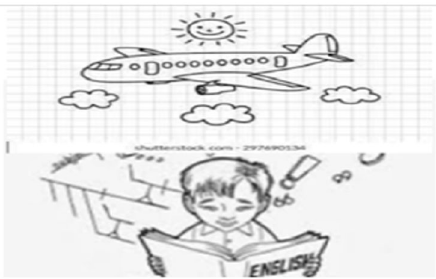
Fig. 2 G1 ’ s adapted metaphorical representation. This fi gure shows that EFL learners believe that learning English will help them to communicate with people from different parts of the world.